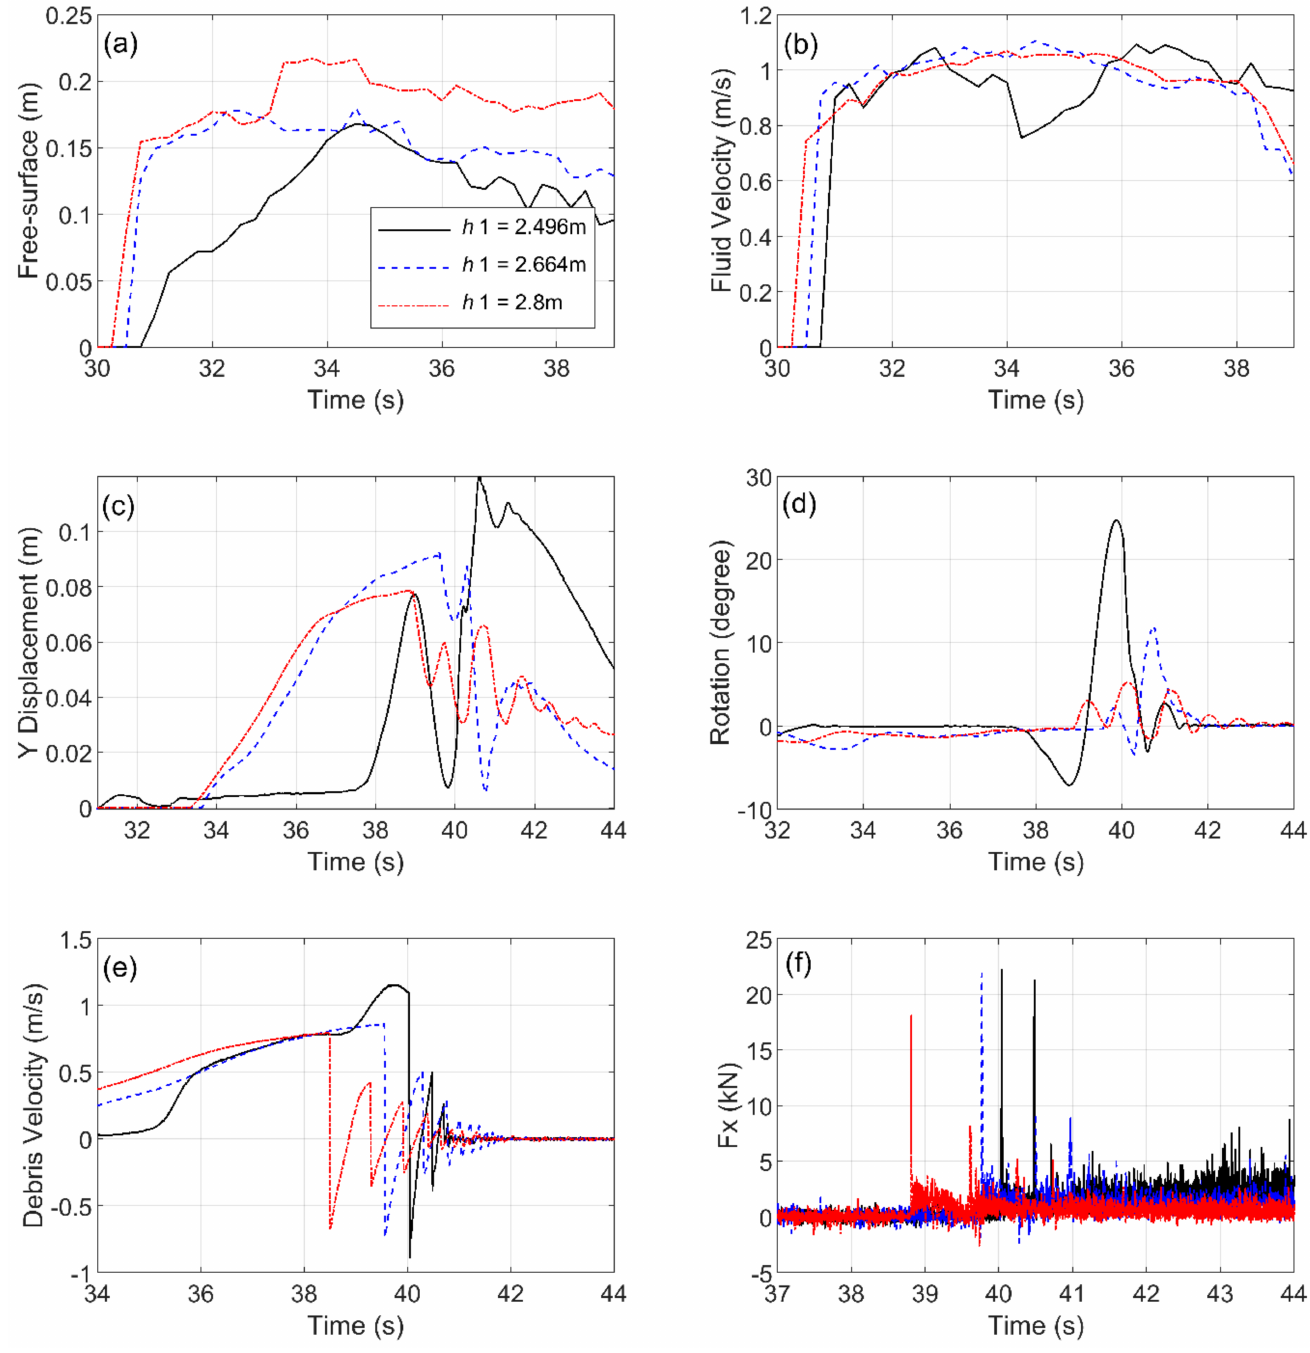
Figure 16. Time histories of the free surface, fluid velocity, motion of the debris (y displacement and rotation), debris velocity and debris impact force on the column. Numerical results of free debris for T erf = 40 s and three water depths with h 1 = 2.496, 2.664 and 2.8